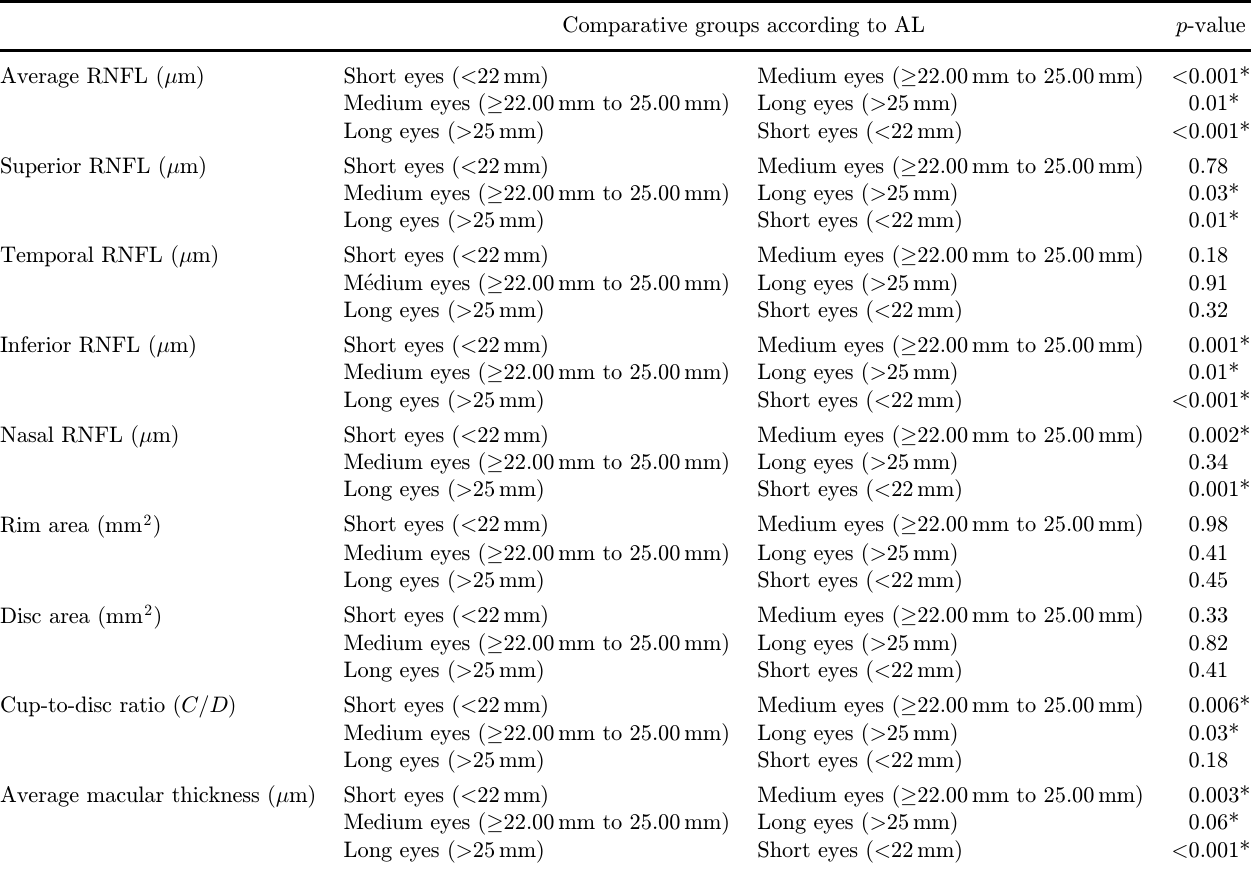
Table 3b. Post hoc analysis to determine pairwise di®erences among groups classi¯ed according to AL (Games – Howell post hoc